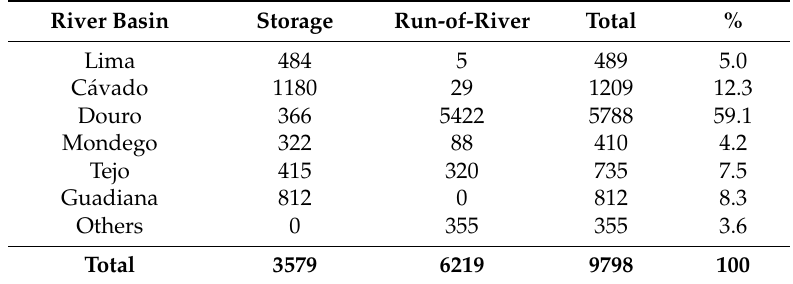
Table 7. Hydropower generation (GWh) by type of plant and river basin in 2015 [3]. River Basin